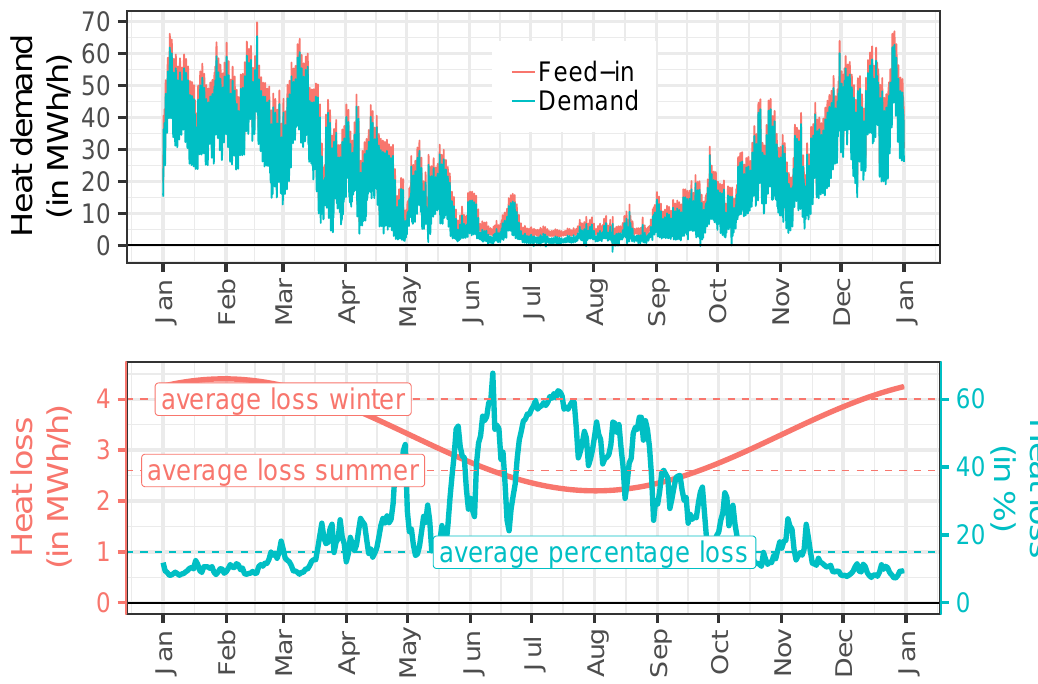
Figure 1. ( Top ): Measured hourly feed-in heat (red line) and derived hourly heat demand (blue line) in the district heating grid of REFUNA. ( Bottom ): Approximated cosine function of the time-varying losses in the REFUNA grid to derive the hourly heat demand (red line, left y-axis) and percentage heat losses (blue line, right